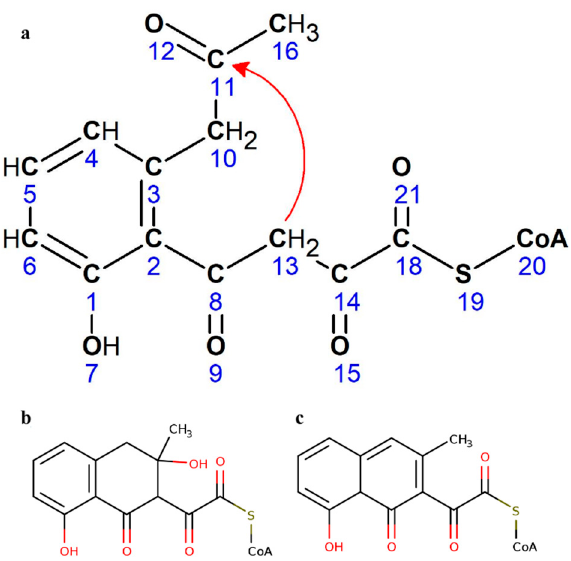
Figure 2. Possible structures of predicted intermediate ( a ) Cyclization of OMB CoA. ( b ) Structure 1 possible for the predicted intermediate. ( c ) Structure 2 possible for the predicted intermediate.